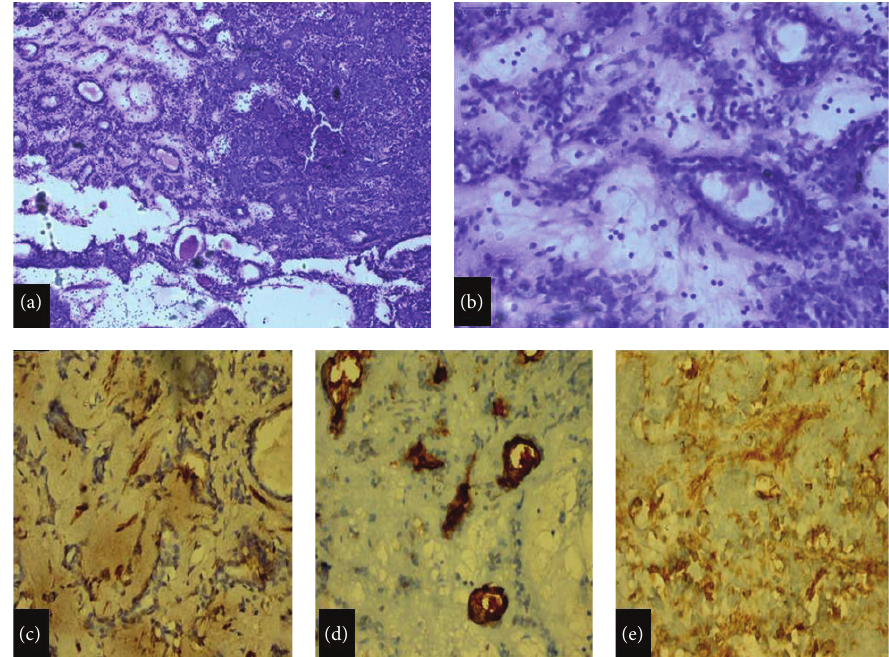
Figure 2: Chondroid syringoma (a) branching tubular epithelial cells in basophilic stroma (H&E, × 50). (b) Tubular lumina lined by cuboidal cells (luminal) and flat cells (periphery) (H&E, × 400). (c) Outer cell layer showing S-100 positivity (Immunoperoxidase, × 100). (d) Luminal cells showing CEA positivity (Immunoperoxidase, × 100). (e) Outer cell layer showing Vimentin positivity (Immunoperoxidase, ×